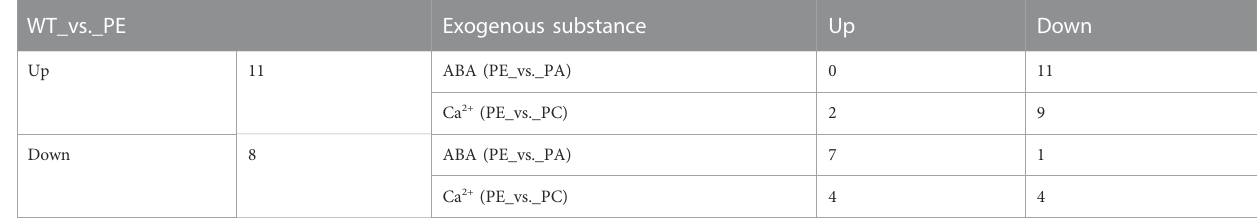
TABLE 4 Number of differentially expressed tomato cyclic nucleotide-gated ion channel genes in the treatment comparison groups.